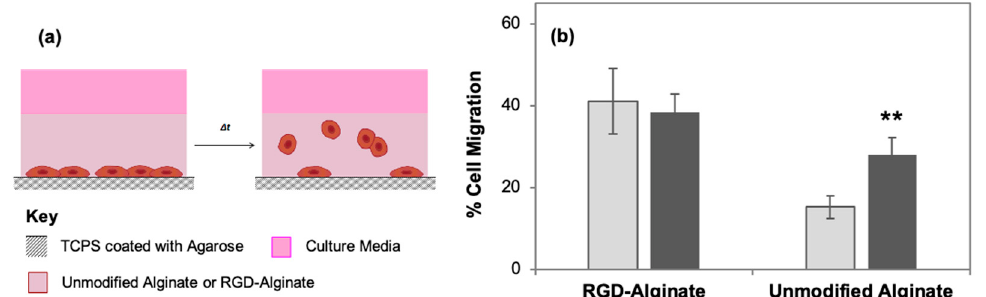
Figure 4. ( a ) Schematic of 2.5D cell migration platform to study the role of stiffness gradients in cell migration; the stiffness gradient can be modified by changing the stiffness of either agarose or alginate, or that of both. ( b ) Migration of U87 cells cultured on TCPS coated with either 0.5% agarose (light grey) or 3% agarose (dark grey) into 0.5% RGD-modified or unmodified alginate gels after three days. Error bars represent the standard deviation of three biological samples. Statistical significance was independently evaluated for TCPS coated with 3% agarose samples relative to TCPS coated with 0.5% agarose samples using a two-tailed t -test evaluated with a 95% (*) or 99% (**) confidence interval.